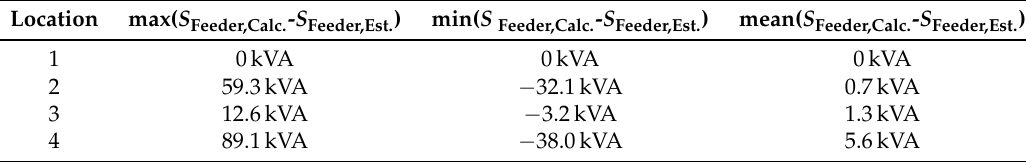
Table 6. Estimation faults for the feeder power for different